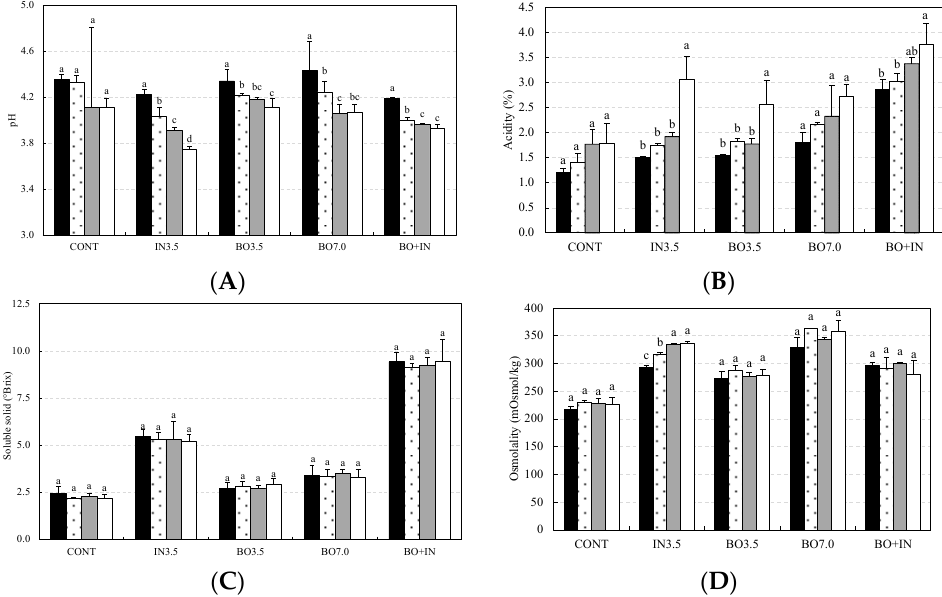
Figure 1. The pH ( A ), acidity ( B ), soluble solid content ( C ), and osmolality ( D ) of kefir-fermented soymilk beverages supplemented with inulin and/or bocaiúva powder-pulp at 1 (black bar), 6 (dots), 11 (gray), and 16 (white) days. CONT, without adding ingredients; IN3.5, with the addition of 3.5% inulin ( m / v ); BO3.5, with the addition of 3.5% bocaiúva powder-pulp ( m / v ); BO7.0, with the addition of 7.0% bocaiúva powder-pulp ( m / v ); and BO + IN, with the addition of 3.5% inulin + 3.5% bocaiúva powder-pulp. Different letters indicate a statistical difference between the fermented beverages during the shelf life by the Tukey test ( p < 0.05).